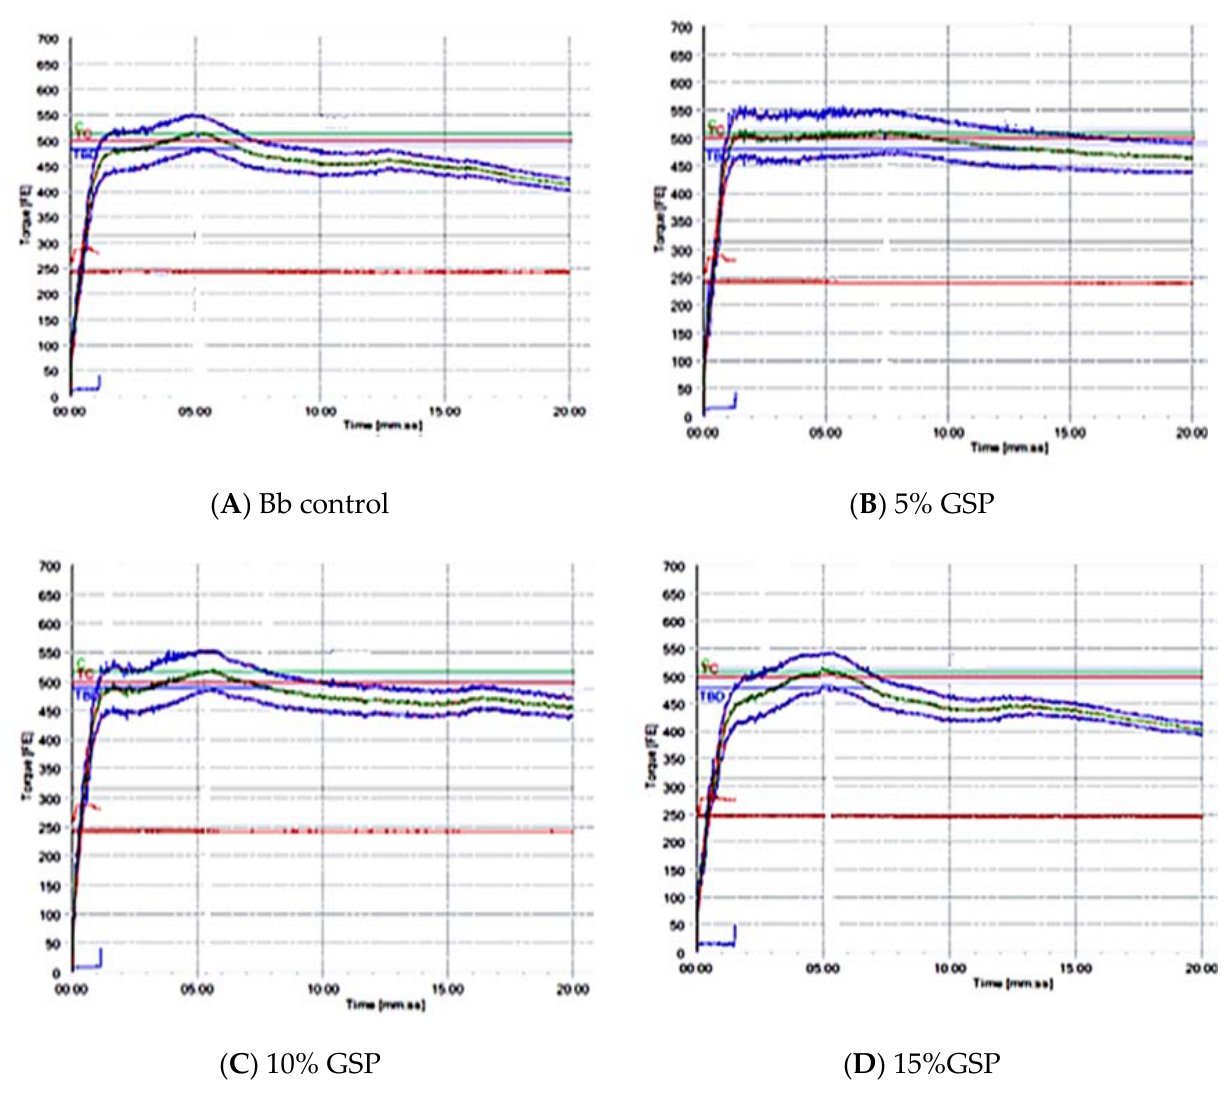
Figure 6. Farinogram for wheat flour and replacement ratios for grape seed powder.